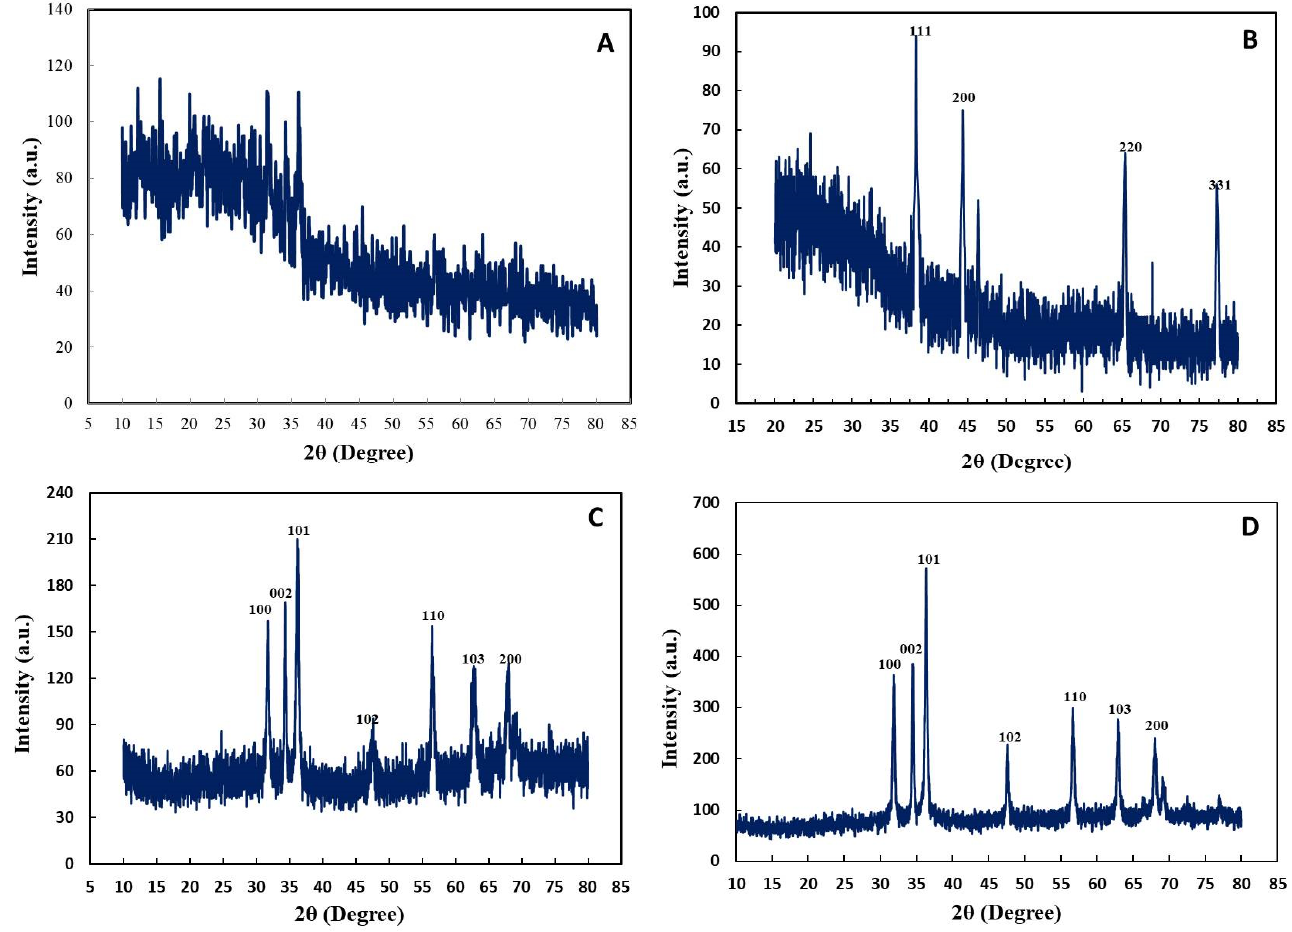
Figure 11. XRD pattern of monometallic NPs. ( A ) Control AgNPs. ( B ) UV-C mediated AgNPs. ( C ) Control ZnONPs. ( D ) UV-C mediated ZnONPs.